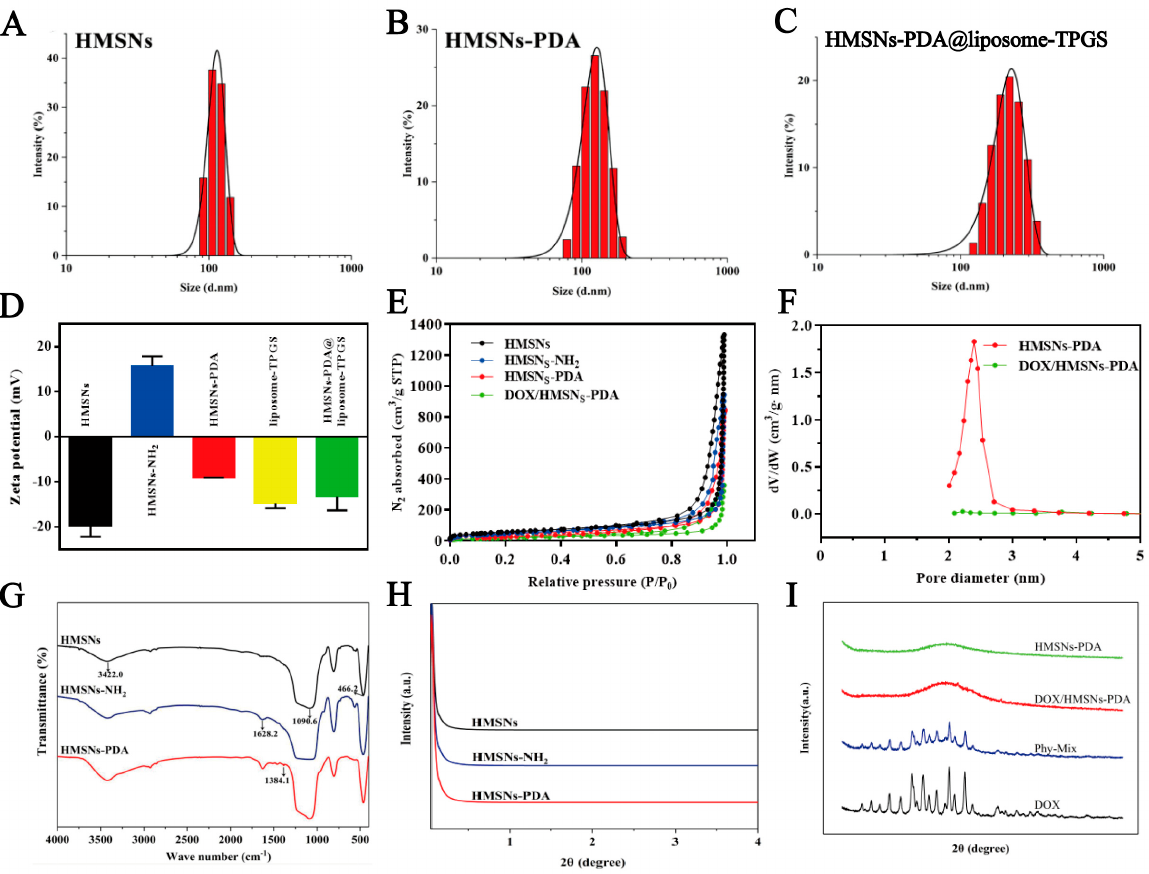
Figure 2. Size distribution curves of HMSNs ( A ), HMSNs-PDA ( B ), and HMSNs-PDA@liposome-TPGS ( C ). ( D ) Zeta potential values of various HMSNs. N 2 adsorption/desorption isotherms ( E ) and BJH pore size distributions of various HMSNs ( F ). ( G ) FT-IR spectra of HMSNs, HMSNs-NH 2 , and HMSNs-PDA. ( H ) SAXS patterns of HMSNs, HMSNs-NH 2 , and HMSNs-PDA. ( I ) XRD patterns of HMSNs-PDA, DOX/HMSNs-PDA, Phy-Mix of DOX, HMSNs-PDA (1:2, w / w ), and DOX.